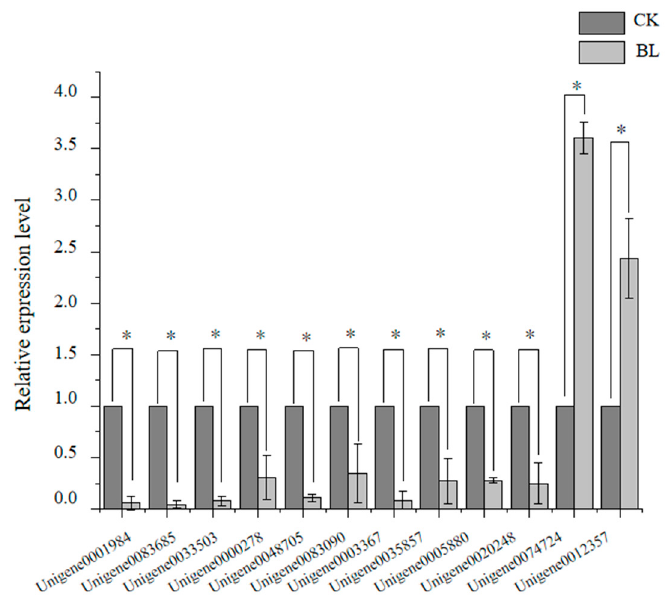
Figure 9. DEGs qRT-PCR analysis. The abscissa represents DEGs, and the ordinate represents the relative gene expression level obtained by real-time PCR (*: p < 0.05, the difference was statistically significant).